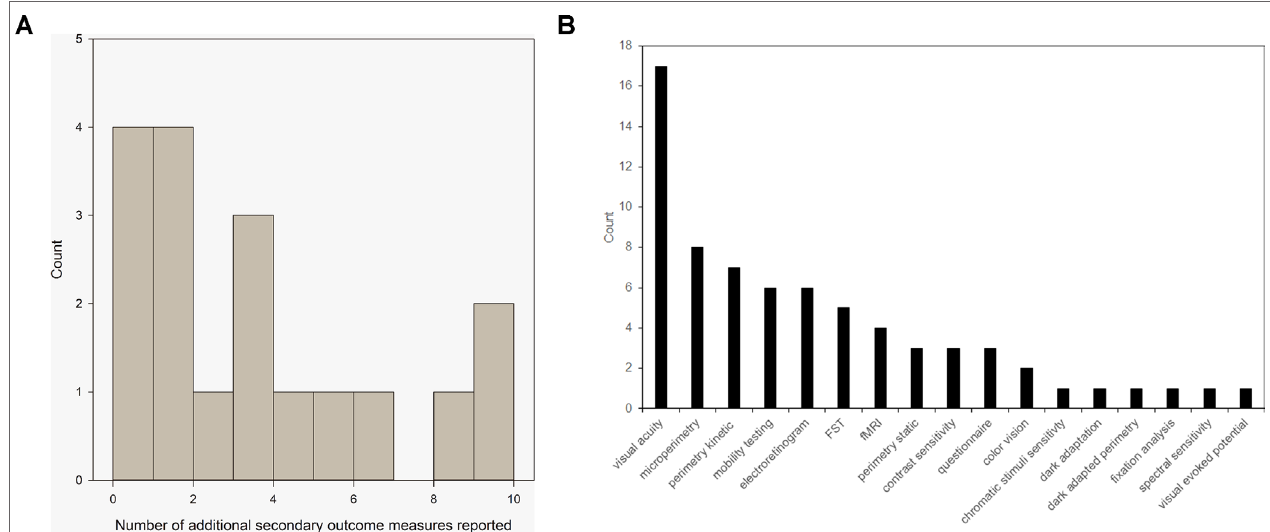
FIGURE 1 | (A) Histogram to show the number of additional outcome measures reported by 79% of trials with peer-reviewed publications. (B) Range of visual function tests currently used as secondary outcome measures in reported ocular gene therapy trials from Table 1